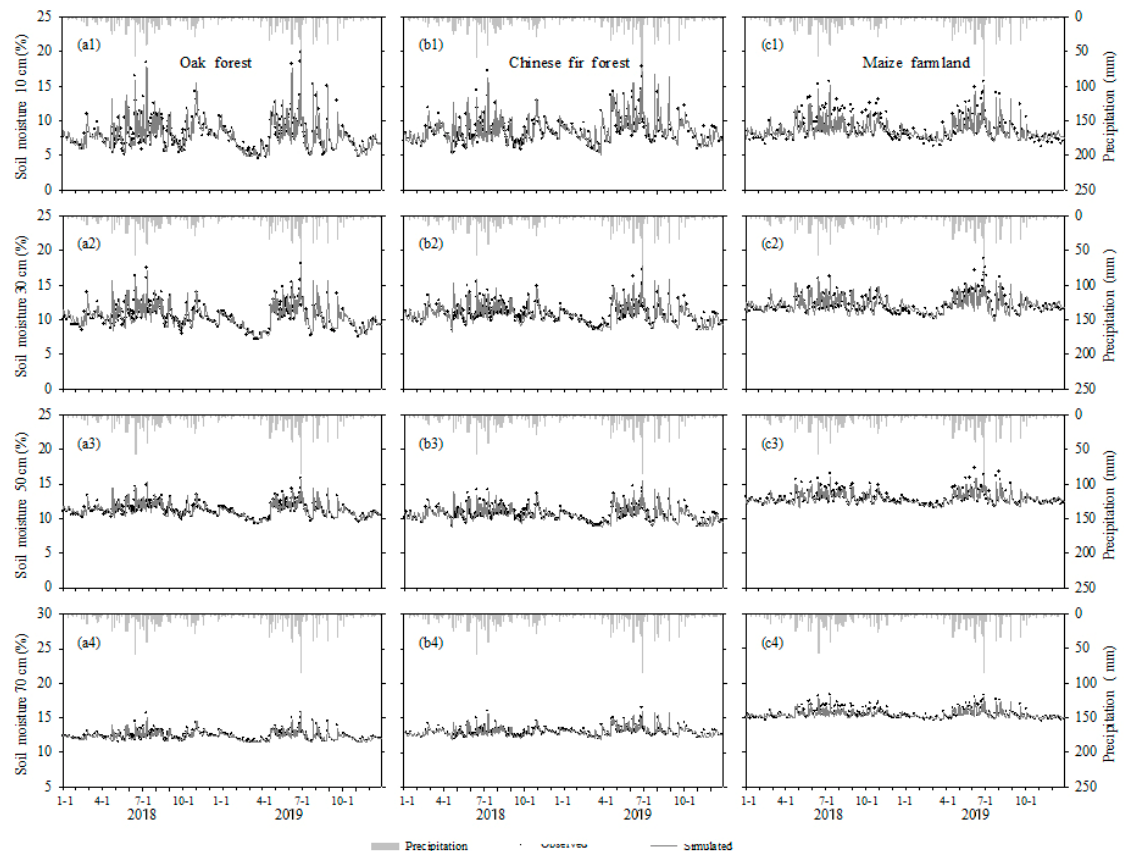
Figure 2. Daily soil moisture: frequency domain reflectometry (FDR) measurements (black circles) and simulated values (gray solid line). Each column from left to right represents oak forest, Chinese fir forest, and maize farmland, respectively. Horizontal ( a1 – c1 , a2 – c2 , a3 – c3 , a4 – c4 ) represents soil moisture in 10 cm, 30 cm, 50 cm, and 70 cm soil depth, respectively.